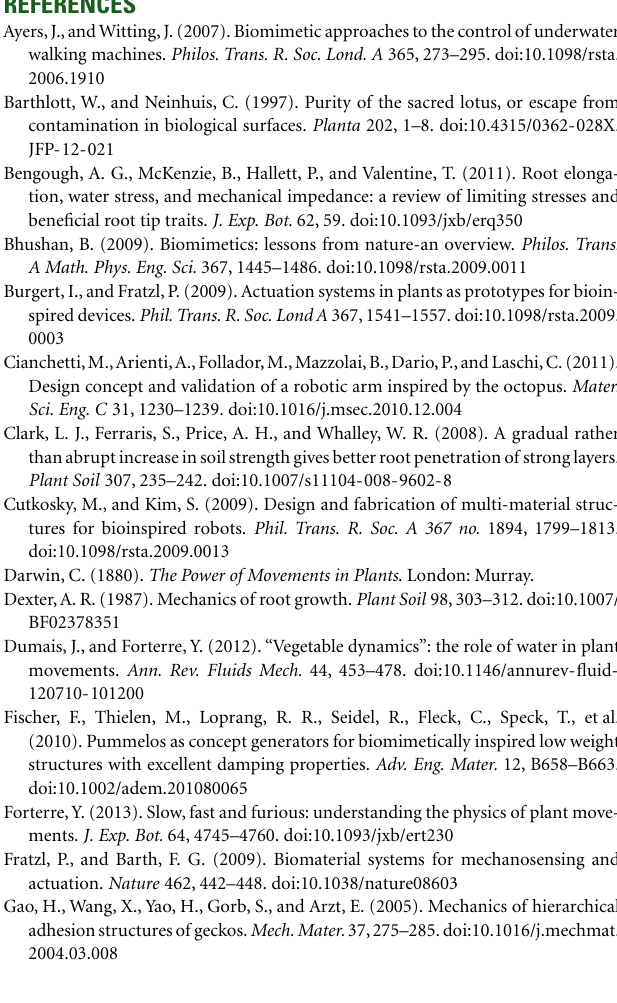
FIGURE 1 |The PLANTOID robot . It integrates two roots that implement the elongation movement and the bending motion with a sensorized tip, respectively. In this prototype, the tip connected to the bending root integrates sensors for touch, humidity, temperature, and gravity.The branches integrate artificial leaves based on PEDOT:PSS material that move in response to changes in environmental